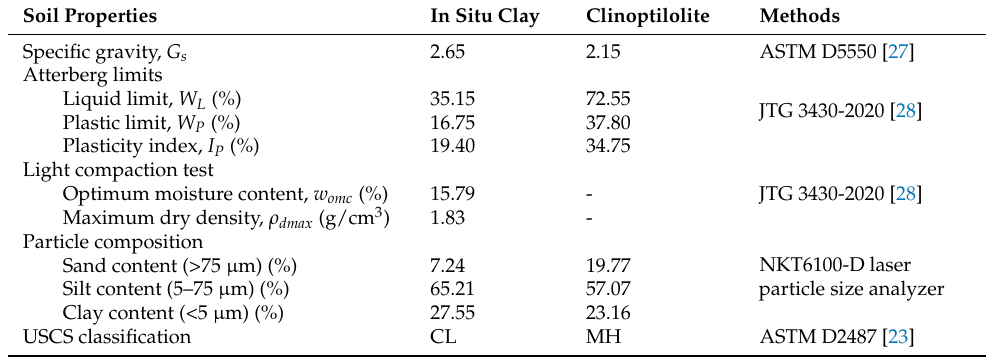
Table 2. The basic physical property indexes of the in situ clay and clinoptilolite.